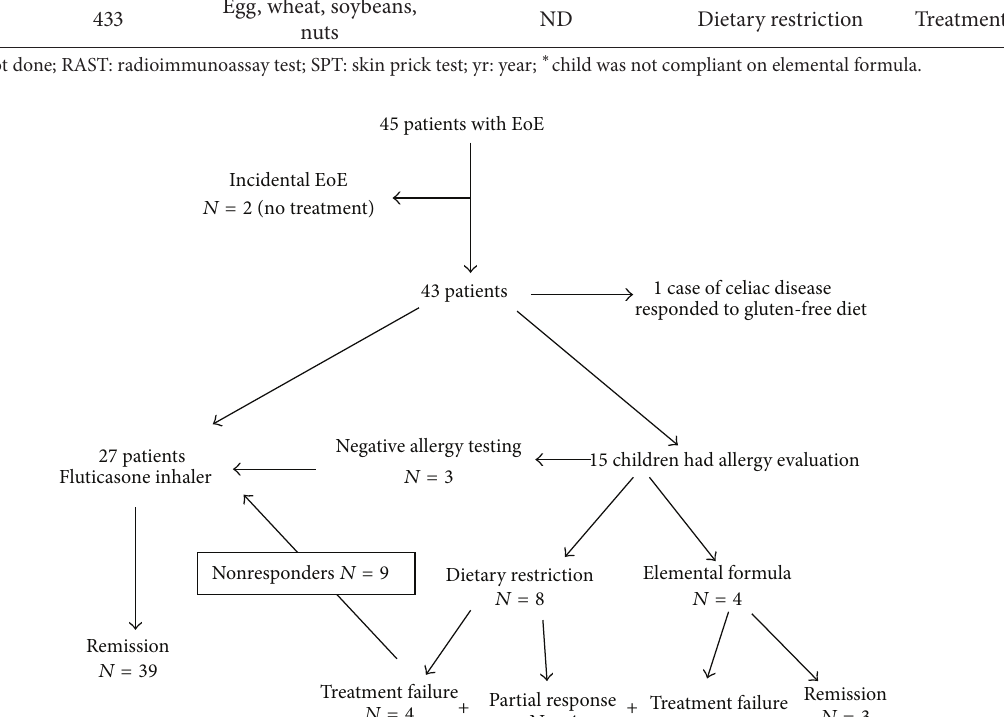
data from North America and Europe: male predominance (male : female ratio = 4 : 1), a majority of patients who are atopic (75%), characteristic endoscopic and histopathologic findings, the chronicity and relapsing nature of EoE, and the effectiveness of a swallowed fluticasone inhaler in treating